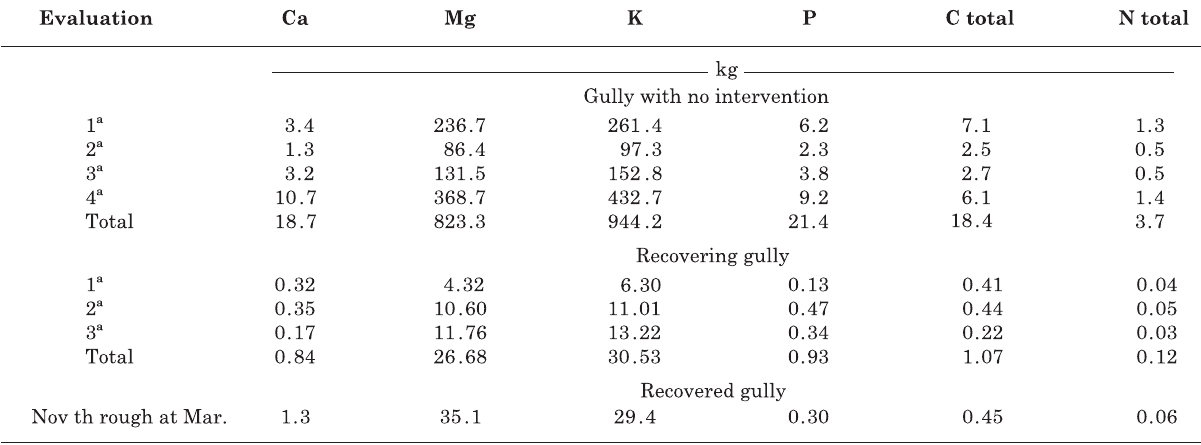
Table 6. Total loss of pseudo-total and total nutrients from the three gullies under study in the summer 2005/